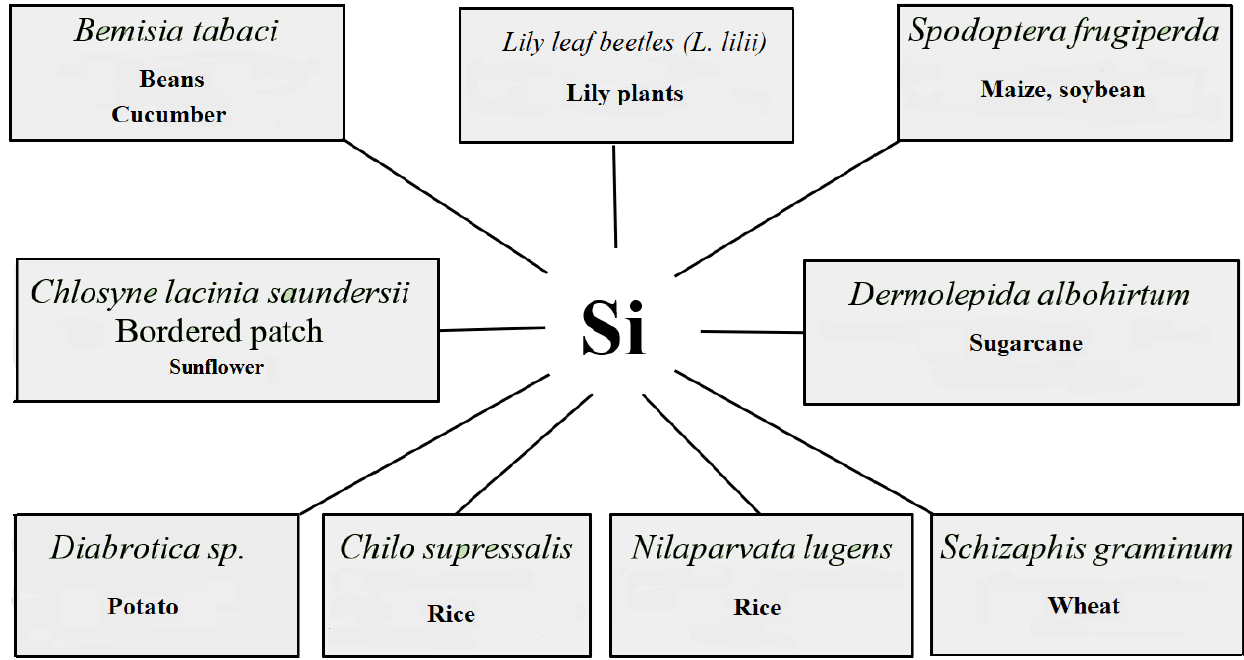
Figure 3. Si application against herbivory pests